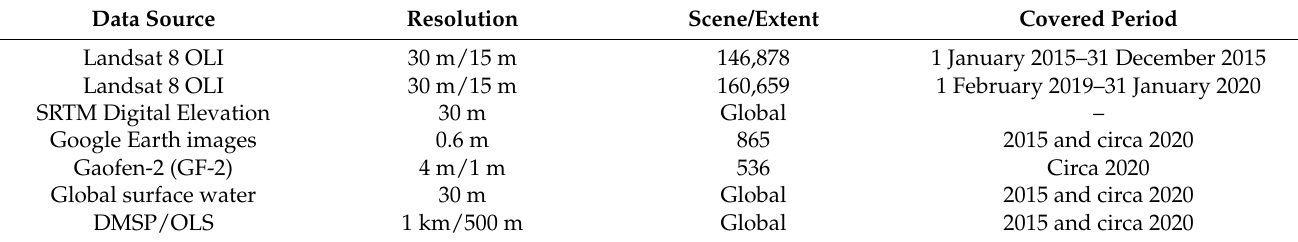
Table 1. The data sources for mapping urban impervious surface area and green space